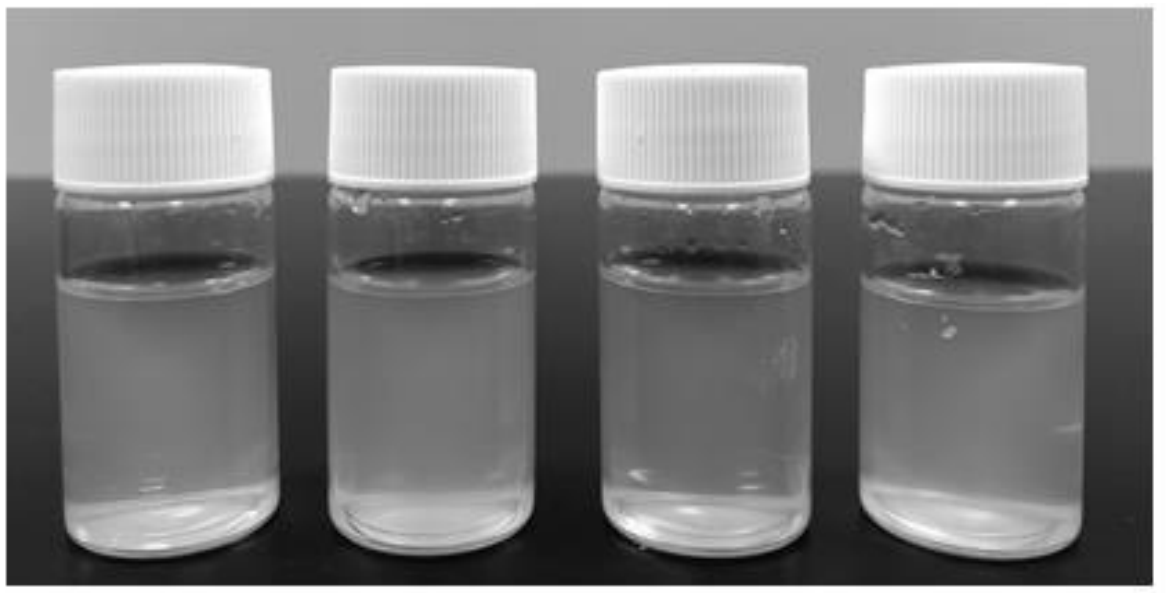
Figure 2. Appearance of SLNs (CSLNs, GA-CSLNs, FA-CSLNs, and GA-FA-CSLNs in order from left to right).